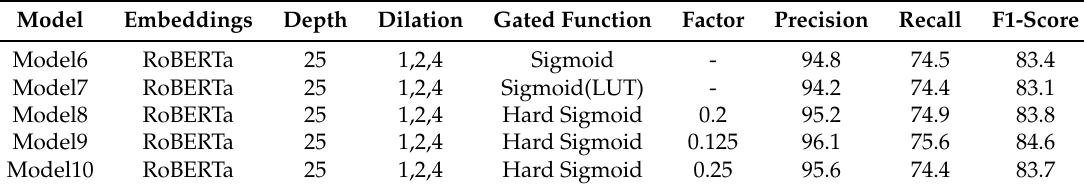
Table 5. Comparison of different gated functions.